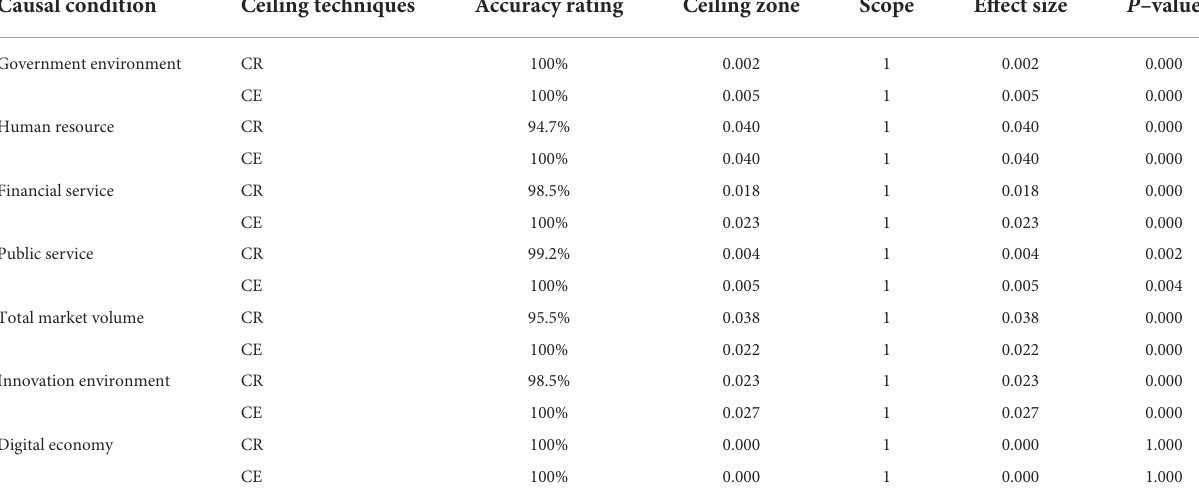
TABLE 3 NCA method test